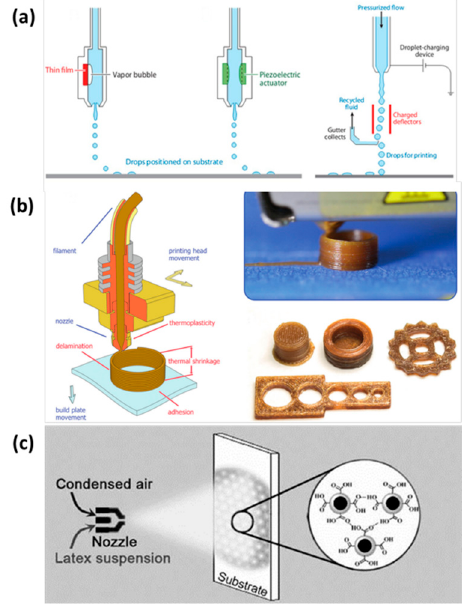
Figure 3. ( a ) Three typical processes of inkjet printing. Left: Thermal inkjet printing. Middle: Piezoelectric inkjet printing. Right: Continuous inkjet printing. Reproduced from [46], with permission from Annual Reviews, 2010; ( b ) Left: The process of extrusion printing technology. Right: Printing cylinder structure with the extrusion printing and the fabricated various structures. Reproduced from [48], with permission from Wiley, 2017; ( c ) Process of spray printing: ink spraying onto the substrate, sprayed layer self-assembling with a hydrogen bonding force. Reproduced from [50], with permission from Wiley, 2009.